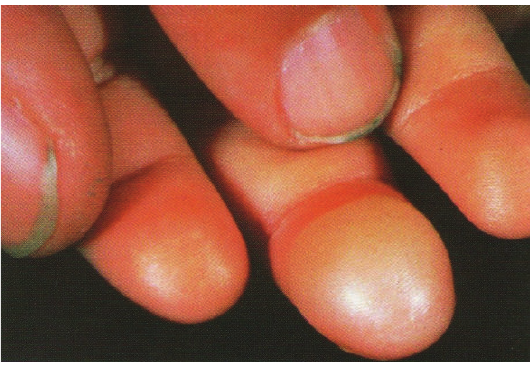
Figure 5: Pyoderma [4, page 262].